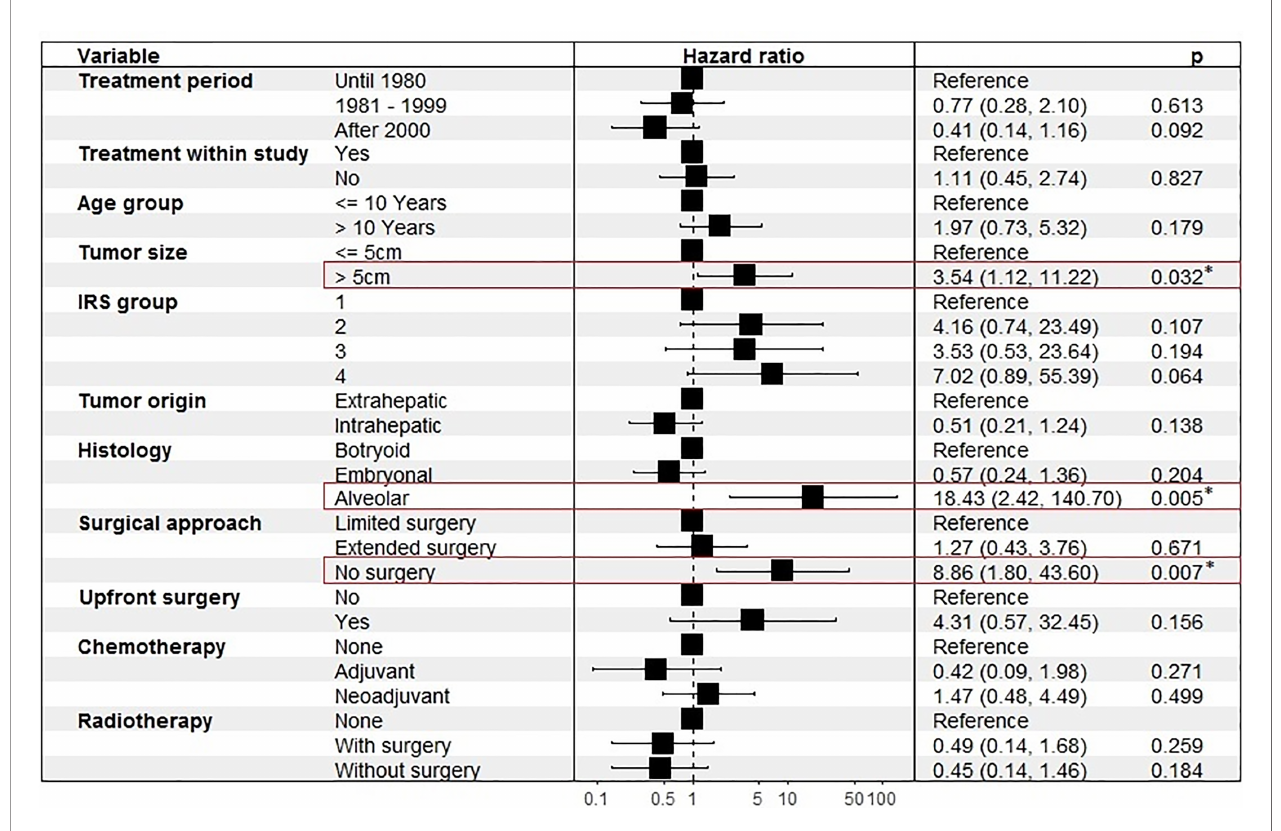
FIGURE 3 | Cox proportional hazards model for risk of death, adjusted for 11 covariates. Numbers in paratheses represent 95%-CI. * marks signi fi cant